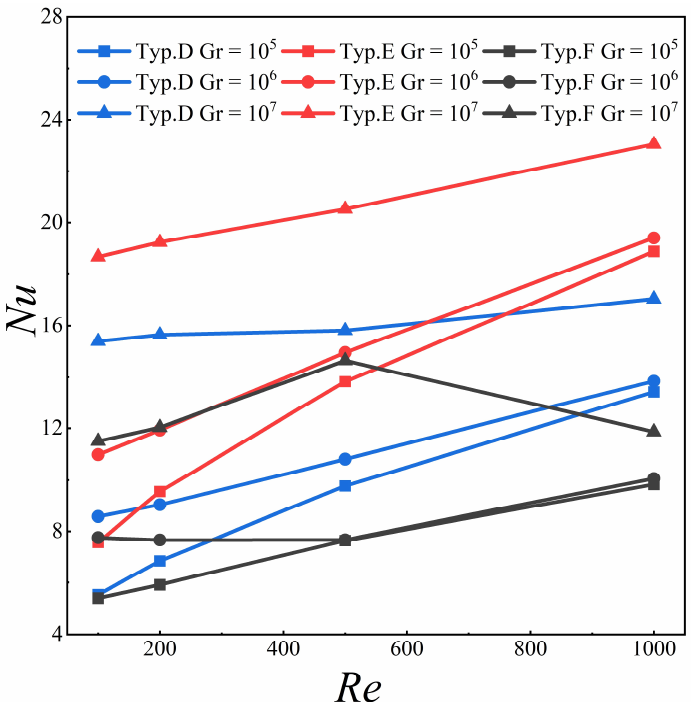
Figure 13. The different heat arrangements (Type D, Type E, and Type F) with Nu and Re for Gr = 10 5 , 10 6 , and 10 7 .